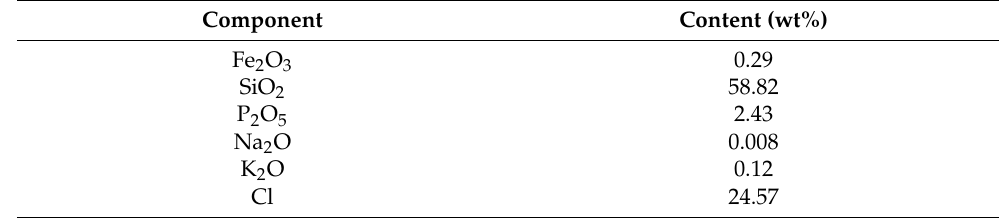
Figure 4. XRD pattern of silica that was synthesized with HCl at pH 2, temperature of 90 °C, 300 rpm, and with 1:4 HCl solution. Table 2. Composition of silica produced by HCl precipitation at pH 2. It was measured with XRF.